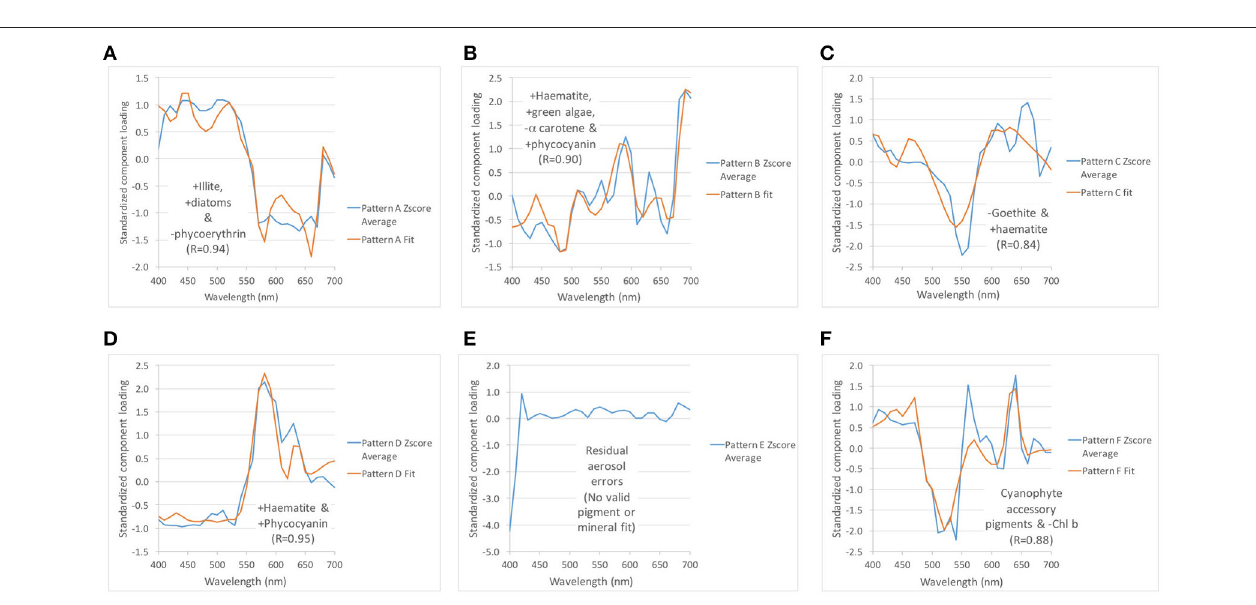
FIGURE 14 | Spectral patterns of varimax-rotated principal component analysis (VPCA) components (A–F) , indicating inferred composition based on forward, stepwise least squares regression. Complete description of the composition of each average component spectral pattern is listed in Table 2 . The quality of the regression fit is indicated by the reported R